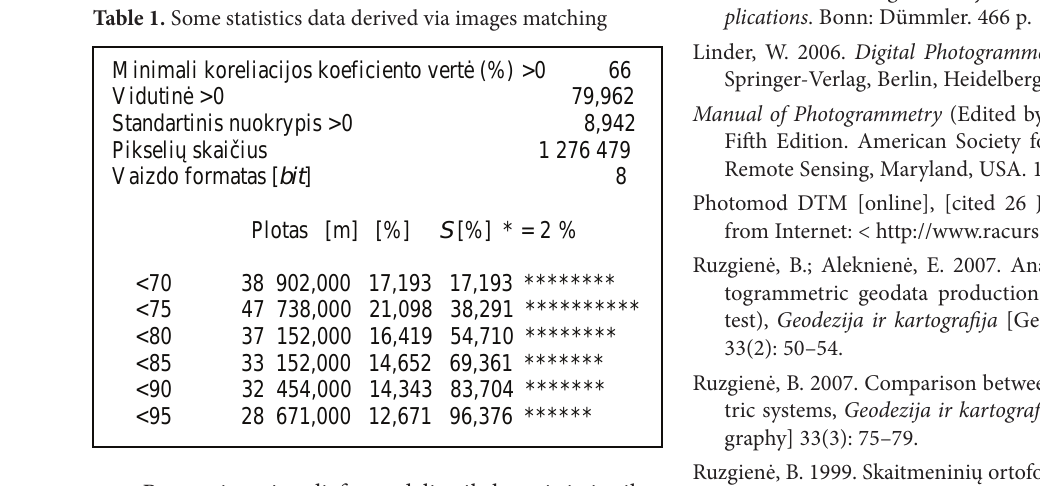
Be to, vietovės reljefo modelio tikslumui tirti